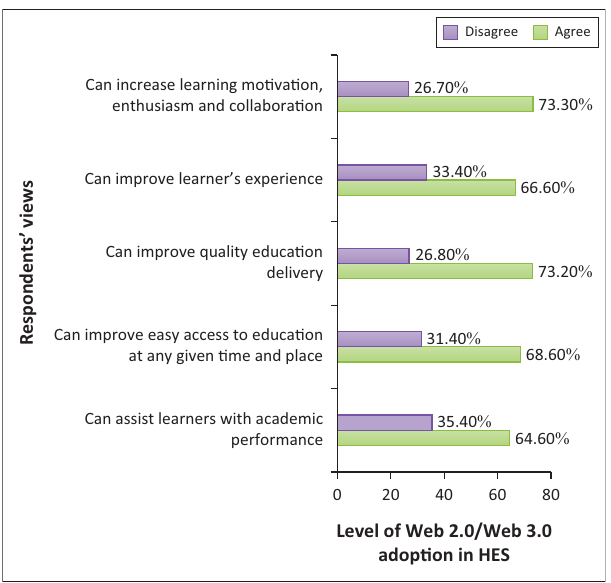
FIGURE 4: Responses regarding Web 2.0 and Web 3.0